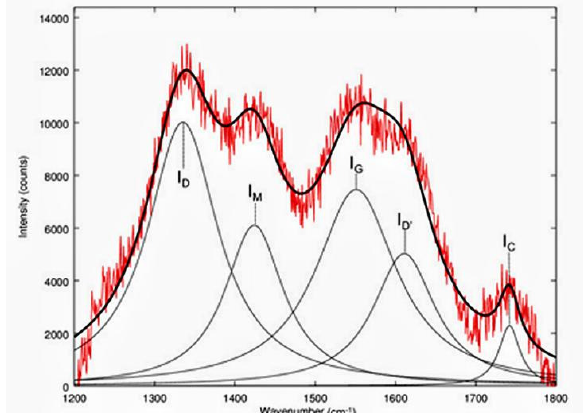
Figure 14. Deconvolution and peak fitting of Raman spectra belong to HNO 3 -H 2 SO 4 treated biochar (BC-M). Peak distribution demonstrated for I D (D band), IM (methylene/methyl band), I G (G band), I D’ (second disordered band), and I C (carbonyl band) [120]. Reprinted with permission from Andrew Anstey et al. (2016). Copyright 2016, Elsevier.